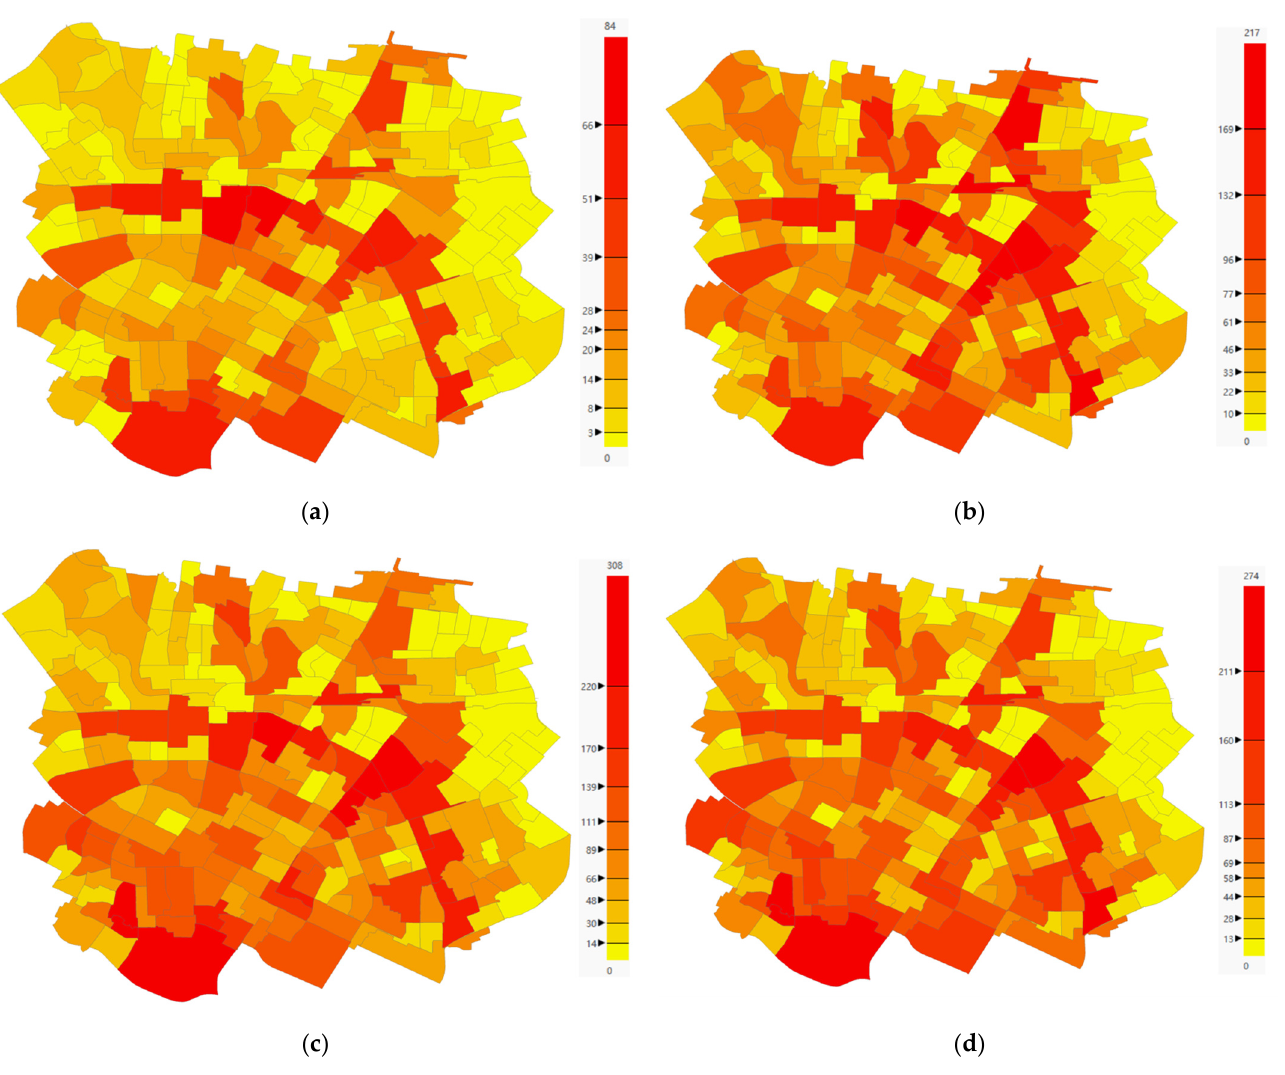
Figure 5. Inflow and outflow heat map of functional areas at different time periods: ( a ) 6:00 a.m.; ( b ) 9:00 a.m.; ( c ) 6:00 p.m.; and ( d ) 9:00 p.m.